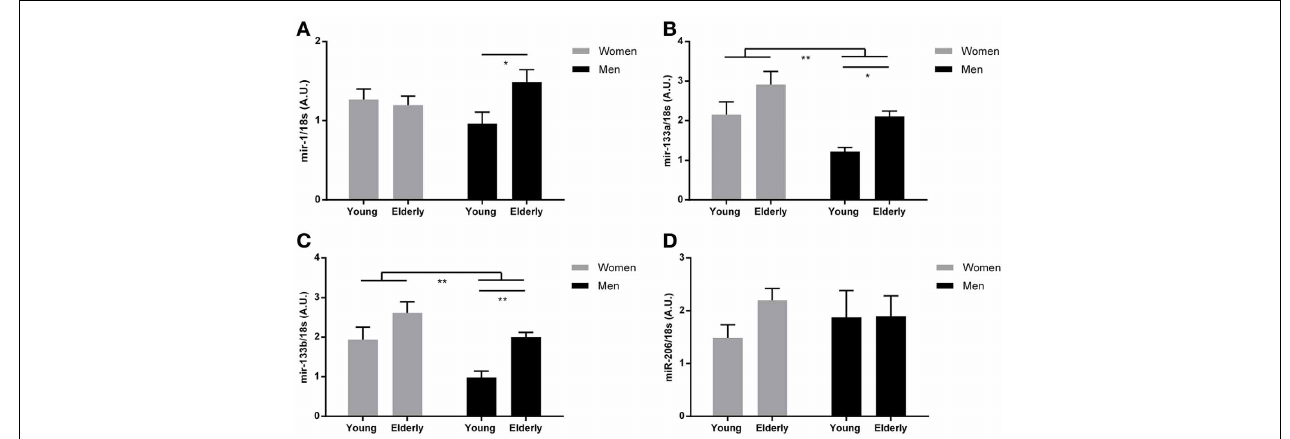
miR-1 expression ( ∗∗ P < 0 . 01). When using Bonferroni multiple comparison post-hoc test it was demonstrated that miR-1 (A) , miR-133a (B) , and miR-133b (C) expression levels were higher in elderly compared to younger men ( ∗ P = 0 . 02, ∗ P = 0 . 03, ∗∗∗ P = 0 . 008, respectively) There was no effect of age or gender on mir-206 expression (D) ( P > 0 . 05). Data are mean ±